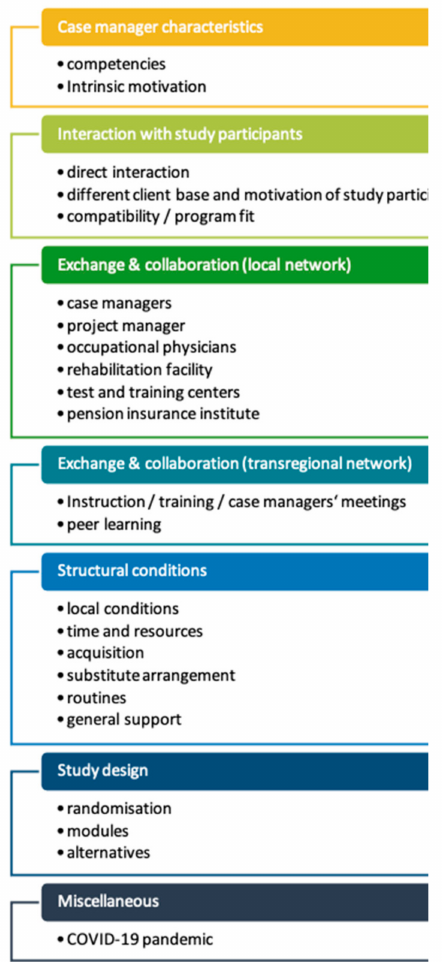
Figure 3. Implementation barriers and